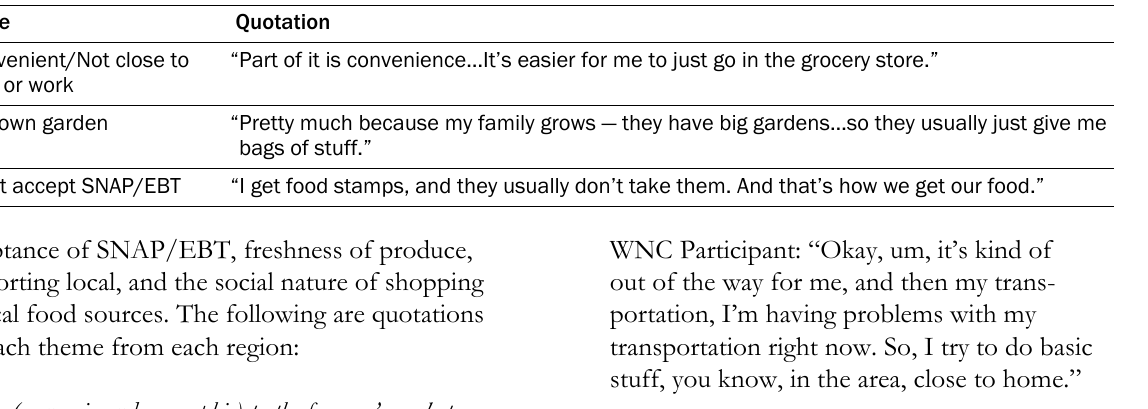
Table 5. WNC Reasons for NOT Procuring Food from Local Food